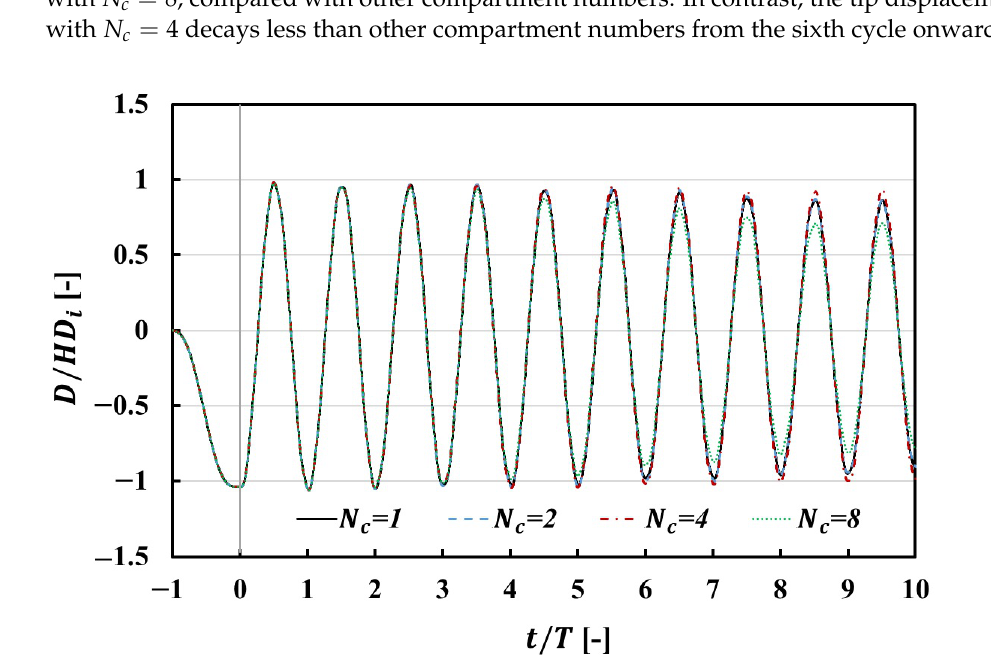
Figure 13. Time history of non-dimensional tip vertical displacement of the system normalised by the initial excitation amplitude over ten cycles for D i =